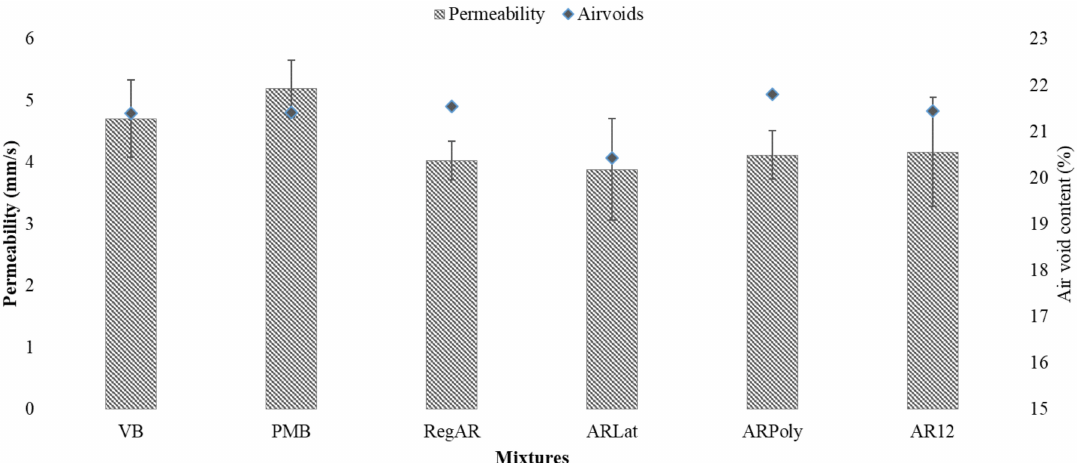
Figure 3. Permeability and air voids of the mixtures, error bars indicate the standard deviation about the mean.